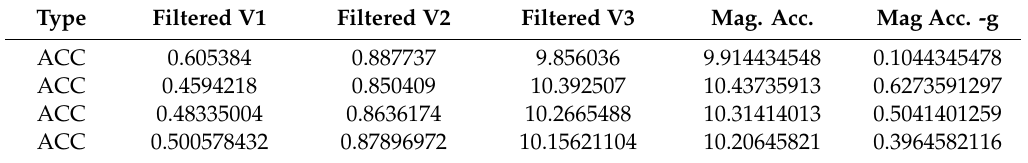
Table 3. Magnitude of the acceleration of the three axis and magnitude without considering